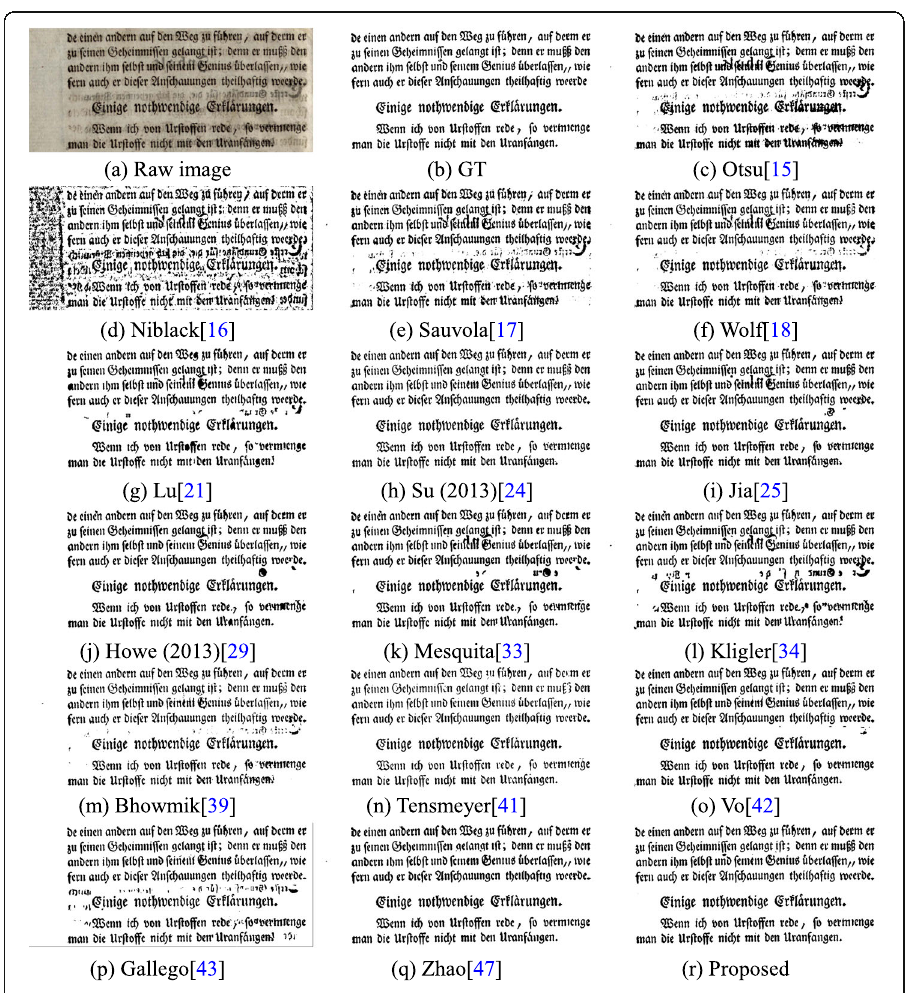
Fig. 7 Binarization results of selected methods for P15 in DIBCO